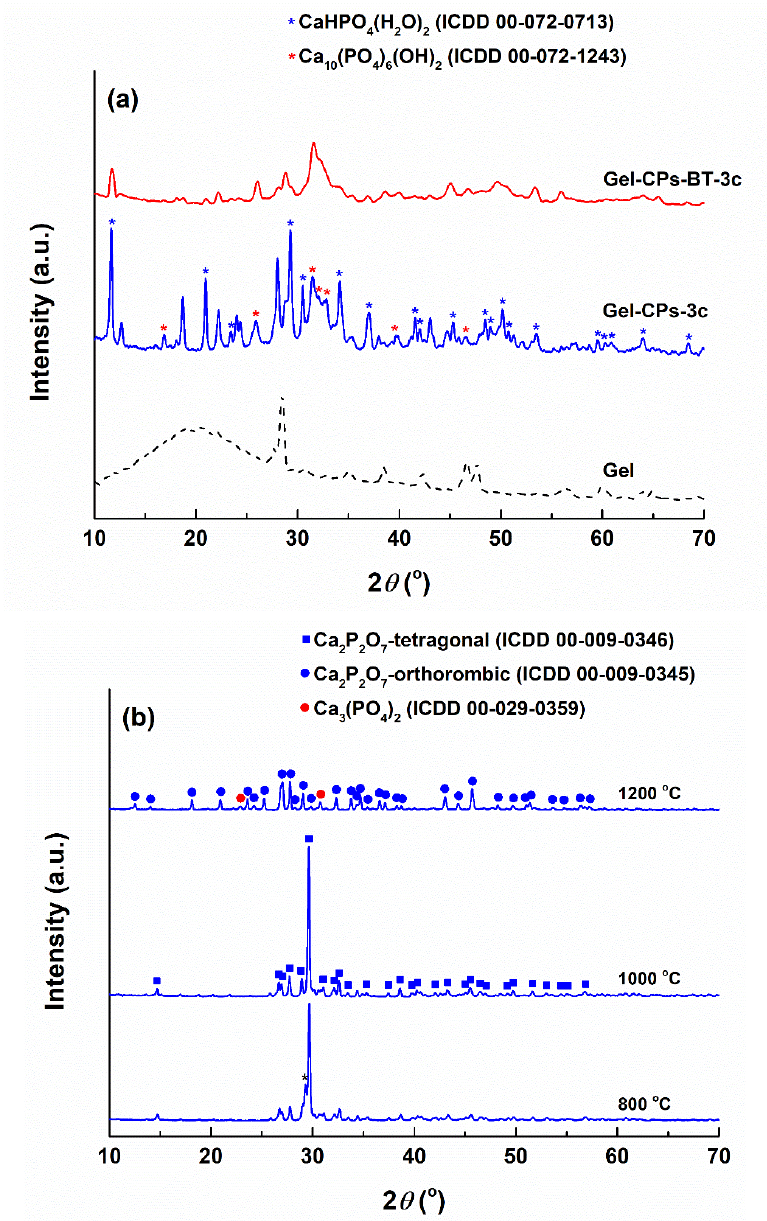
Figure 4. XRD patterns of the obtained materials: ( a ) before the thermal treatments and ( b ) after the thermal treatments of the Gel -CPs-3c composite.